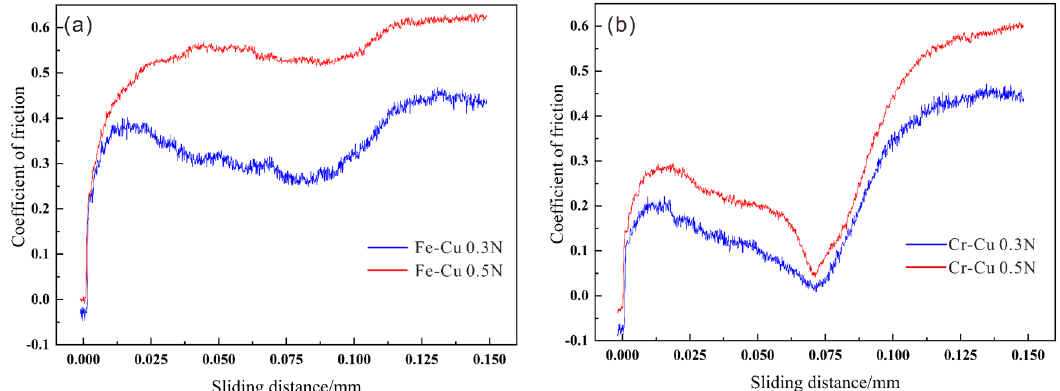
Figure 9. Curves of the coefficient of friction plotted versus the sliding distance in the Cu/Fe and Cr/Cu interface regions under different applied loads: ( a ) Fe/Cu interface regions and ( b ) Cu/Cr interface regions.